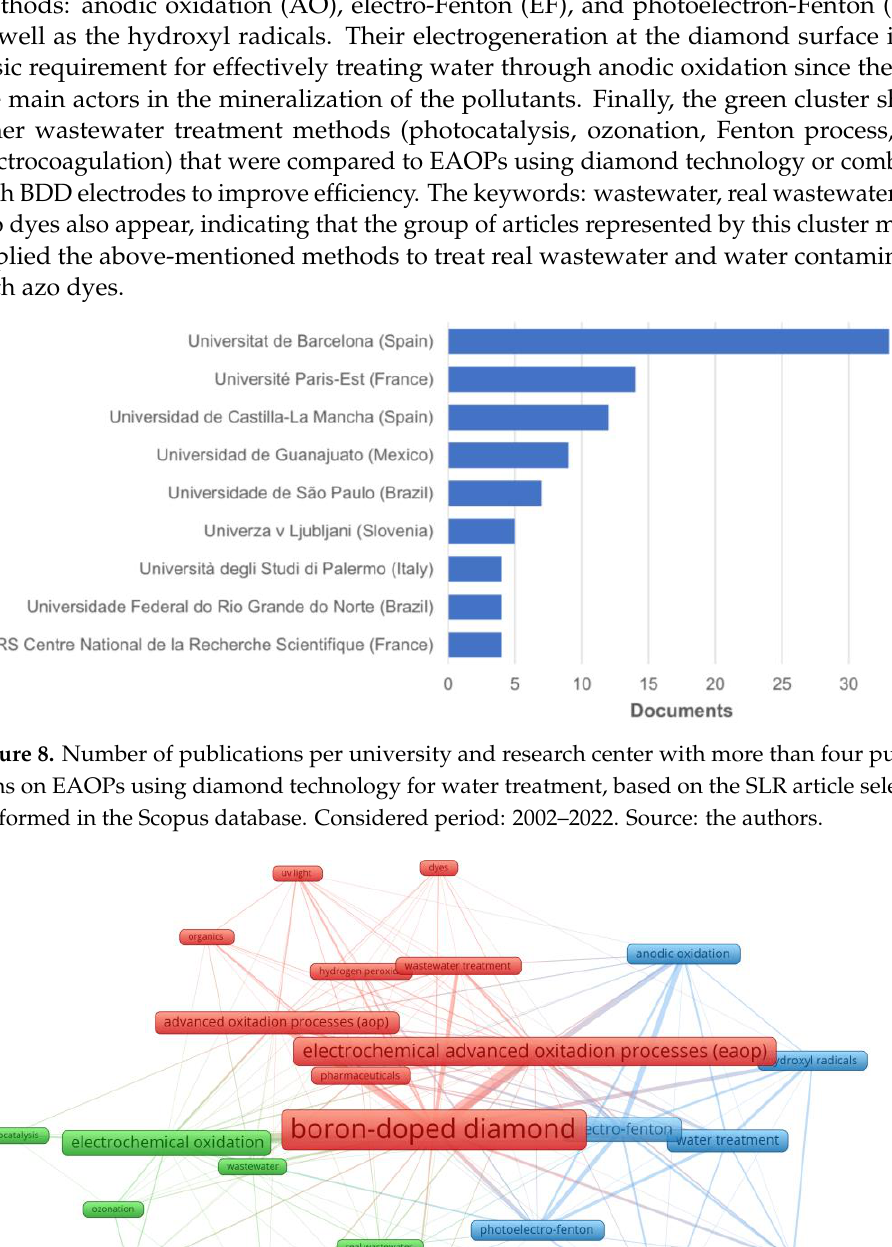
Figure 9. Keywords co-occurrence network (minimum of five occurrences) representation of the trends on the application of EAOPs using diamond technology for water treatment, based on the Scopus database and VOSviewer as the bibliometric mapping software [55,56] (source: the authors). After careful analysis of the methods applied in water treatment mentioned in each of the SLR-selected articles, we built a network map (Figure 10a), along with a chart containing There are three major clusters visible in the keywords network graph. As expected, data on the distribution and frequency of the methods (Figure the largest one (red color) represents mostly the use of BDD electrodes in EAOPs for water treatment. This cluster also shows add-ons (complementary techniques) used in different EAOPs, such as UV light or the generation of hydrogen peroxide. Furthermore, the red cluster also presents the most applied pollutants in degradation studies, such as organics,